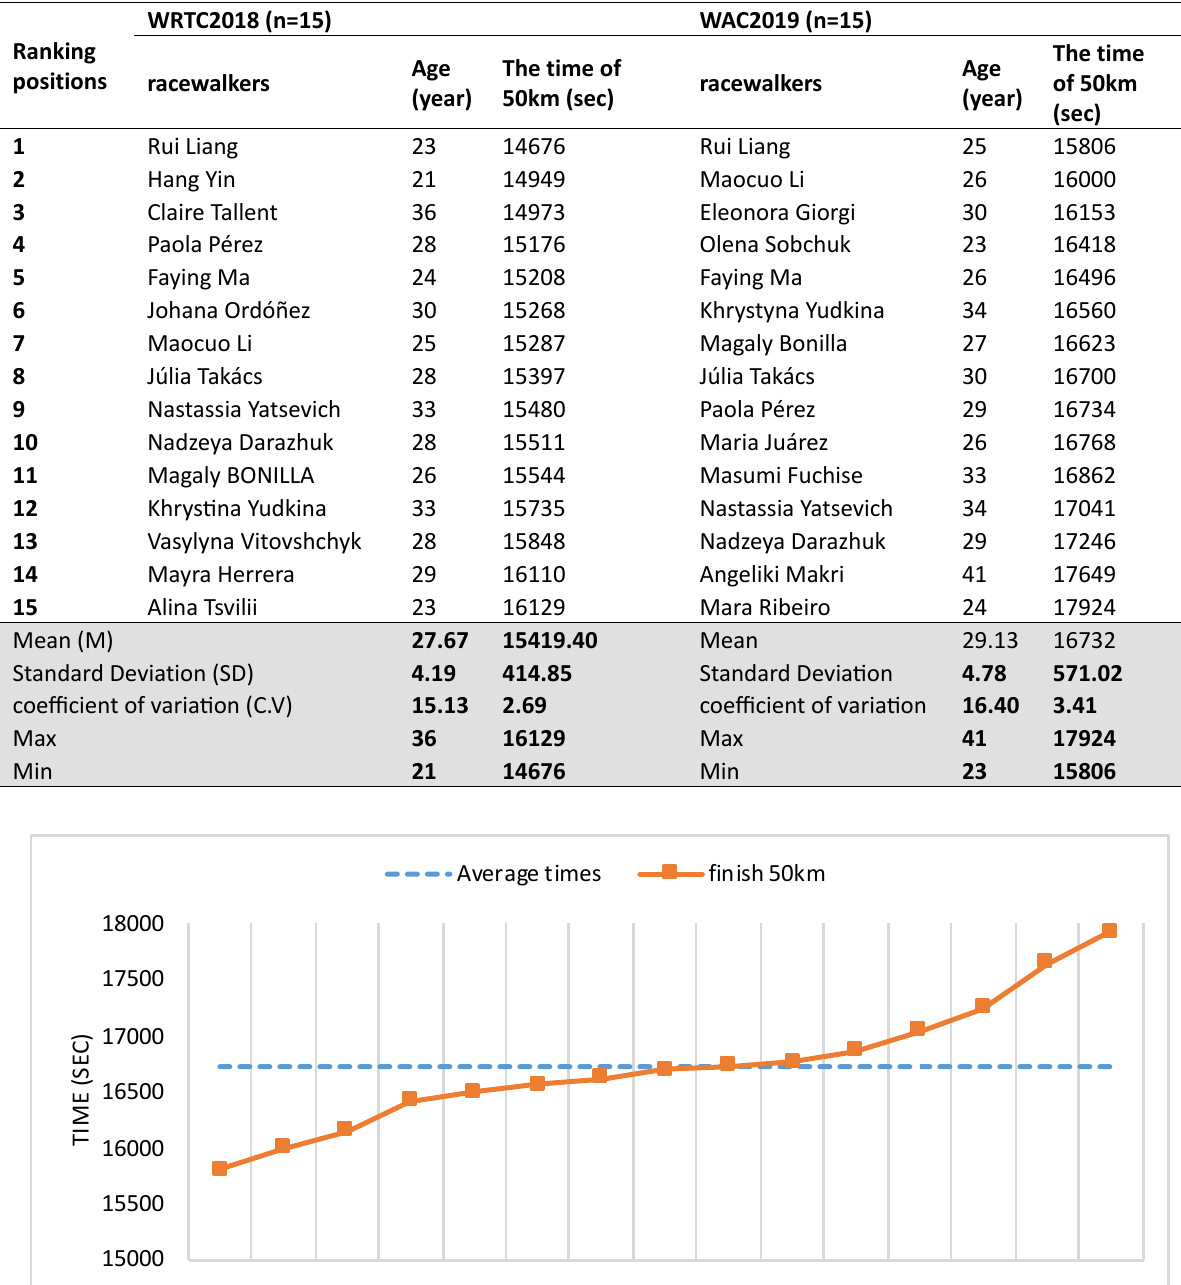
Table 1. Ranking positions, Ages of racewalkers (year), and Performance time (sec) of 50km. N=30